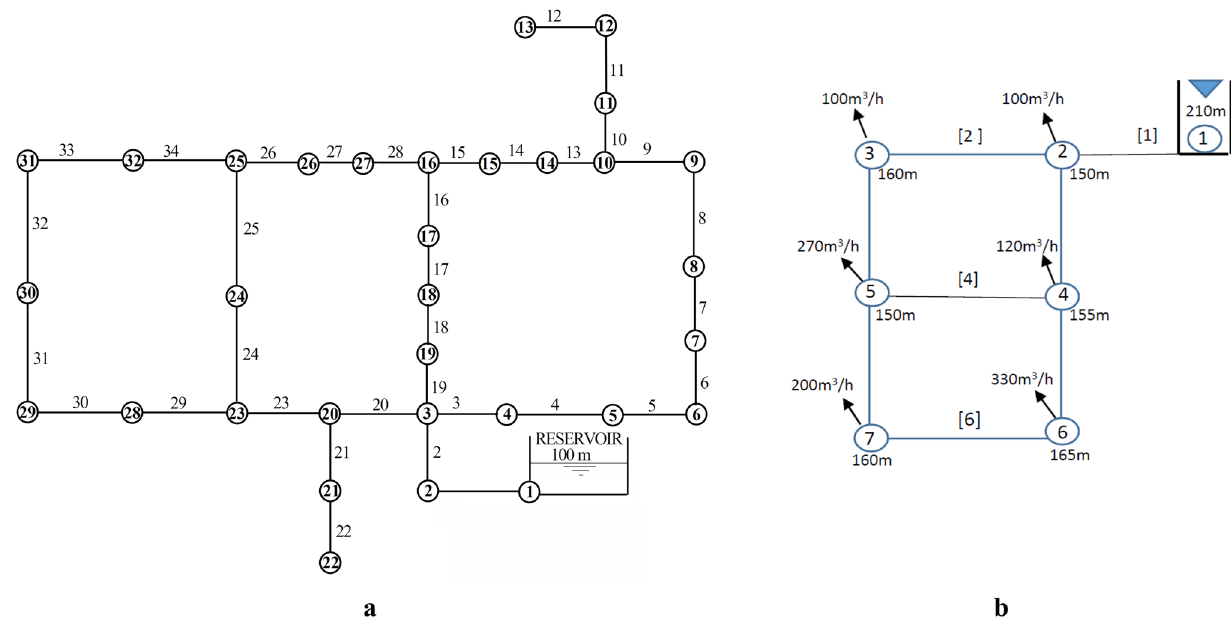
Fig. 1 Networks studied in this research: a the two-loop WDN presented by Alperovits and Shamir (1977) and b the three-loop WDN of Hanoi presented by Fujiwara and Khang 0 Table 1 Available commercial Diameter diameters and cost per meter in two- loop WDN